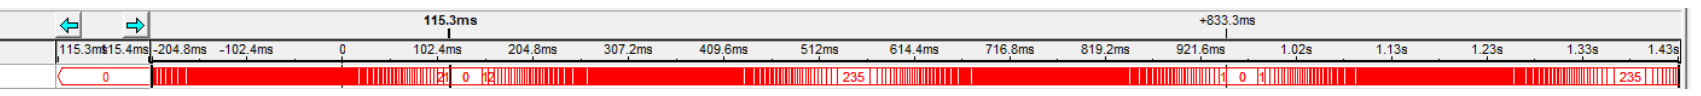
Figure 21. Segment of 16 k-samples of a SPSS stimulus with amplitude of ±30° at 1.2 Hz with D = 100 cm.